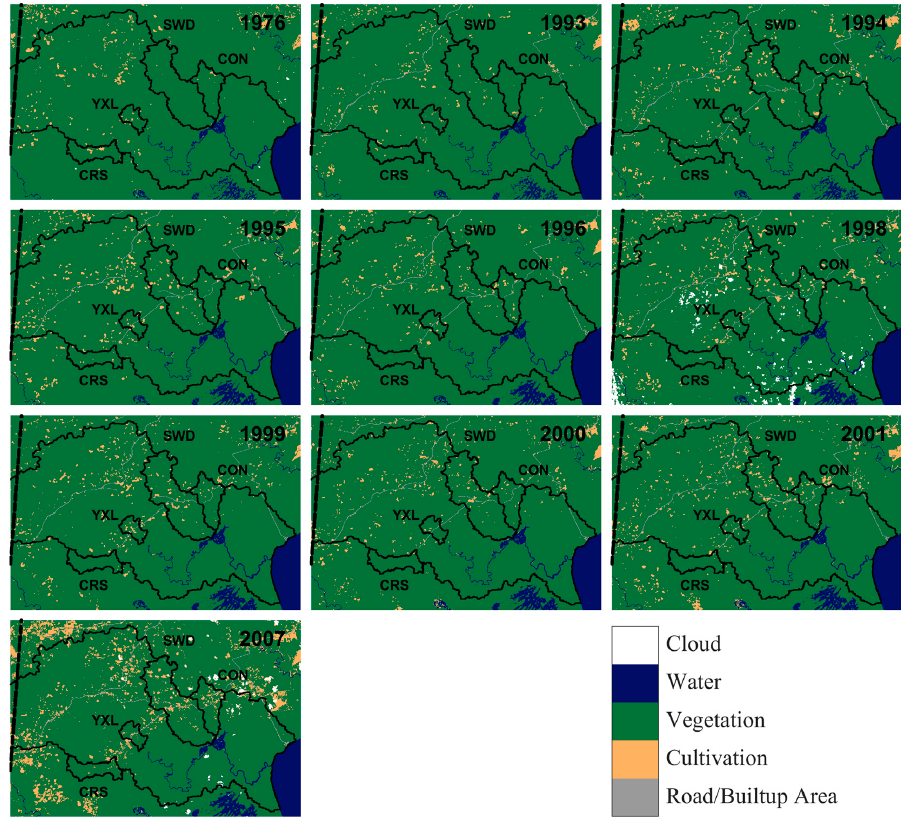
Figure 2. Time series of land use and land cover change (LULCC) classification results between 1976 and 2007 showing minimal expansion of cultivated areas within the greater Temash River watershed or the four smaller study catchments (CRS = Crique Sarco Creek; YXL = Yax Cal Creek; SWD = Sunday Wood Creek; CON = Conejo Creek).